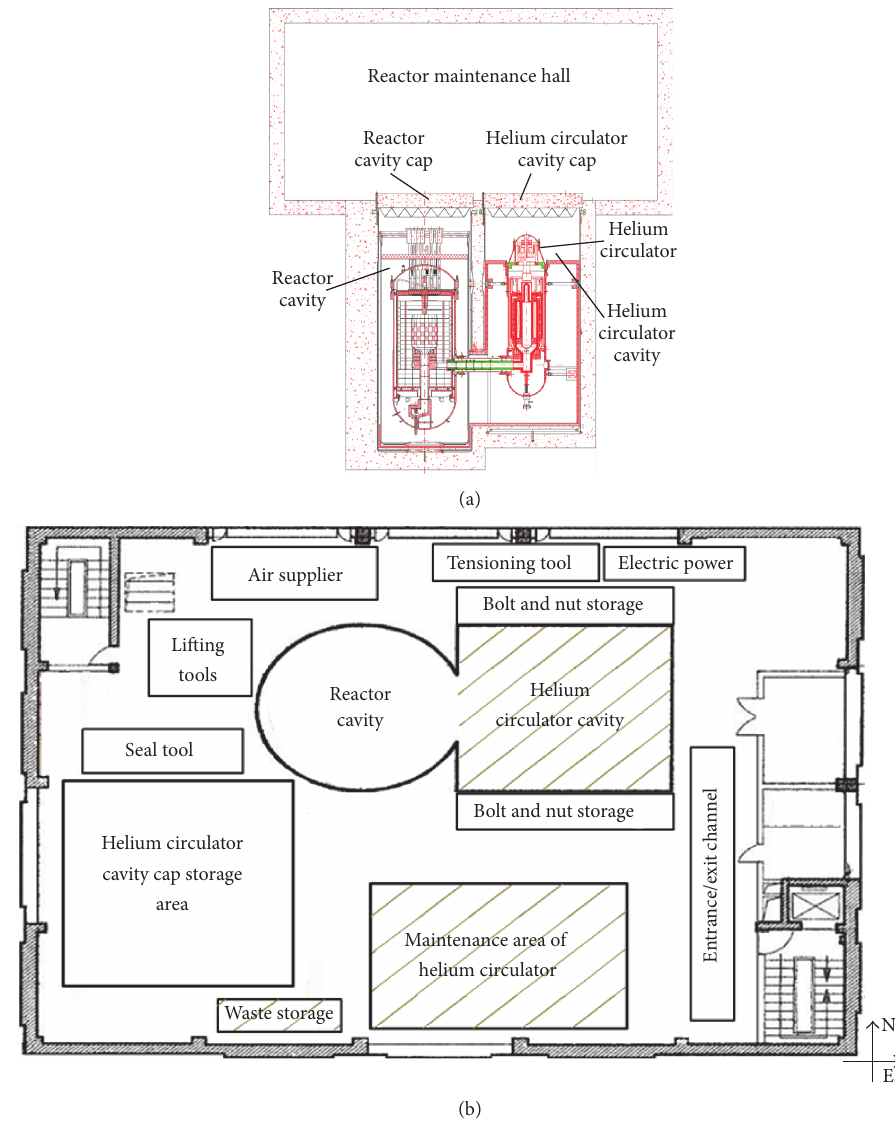
Figure 1: Schematic layout of the work place. (a) Vertical view of the work place. (b) Horizontal layout of the reactor maintenance hall. The three shaded areas were the places where most radioactive work took